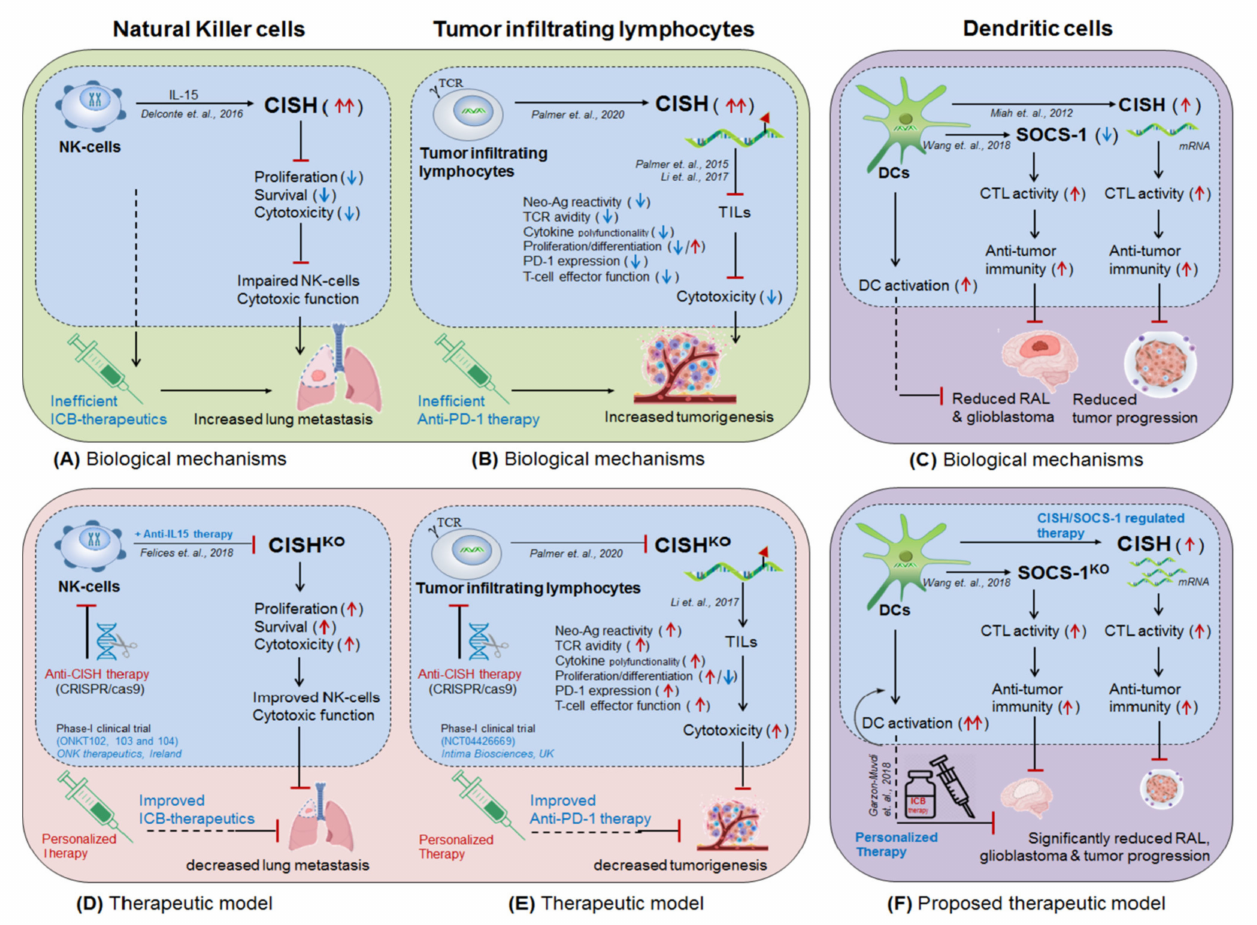
Figure 8. Immunotherapeutic model co-targeting intracellular checkpoint (CISH/SOCS-1) in combination with ICB- therapeutics. ( A ) NK-cell biological mechanism: CISH expression in natural killer cell impairs its cytolytic function by reducing NK-cell proliferation, fitness and survival inside the TME [190] and thus insufficient in protecting lung metastasis